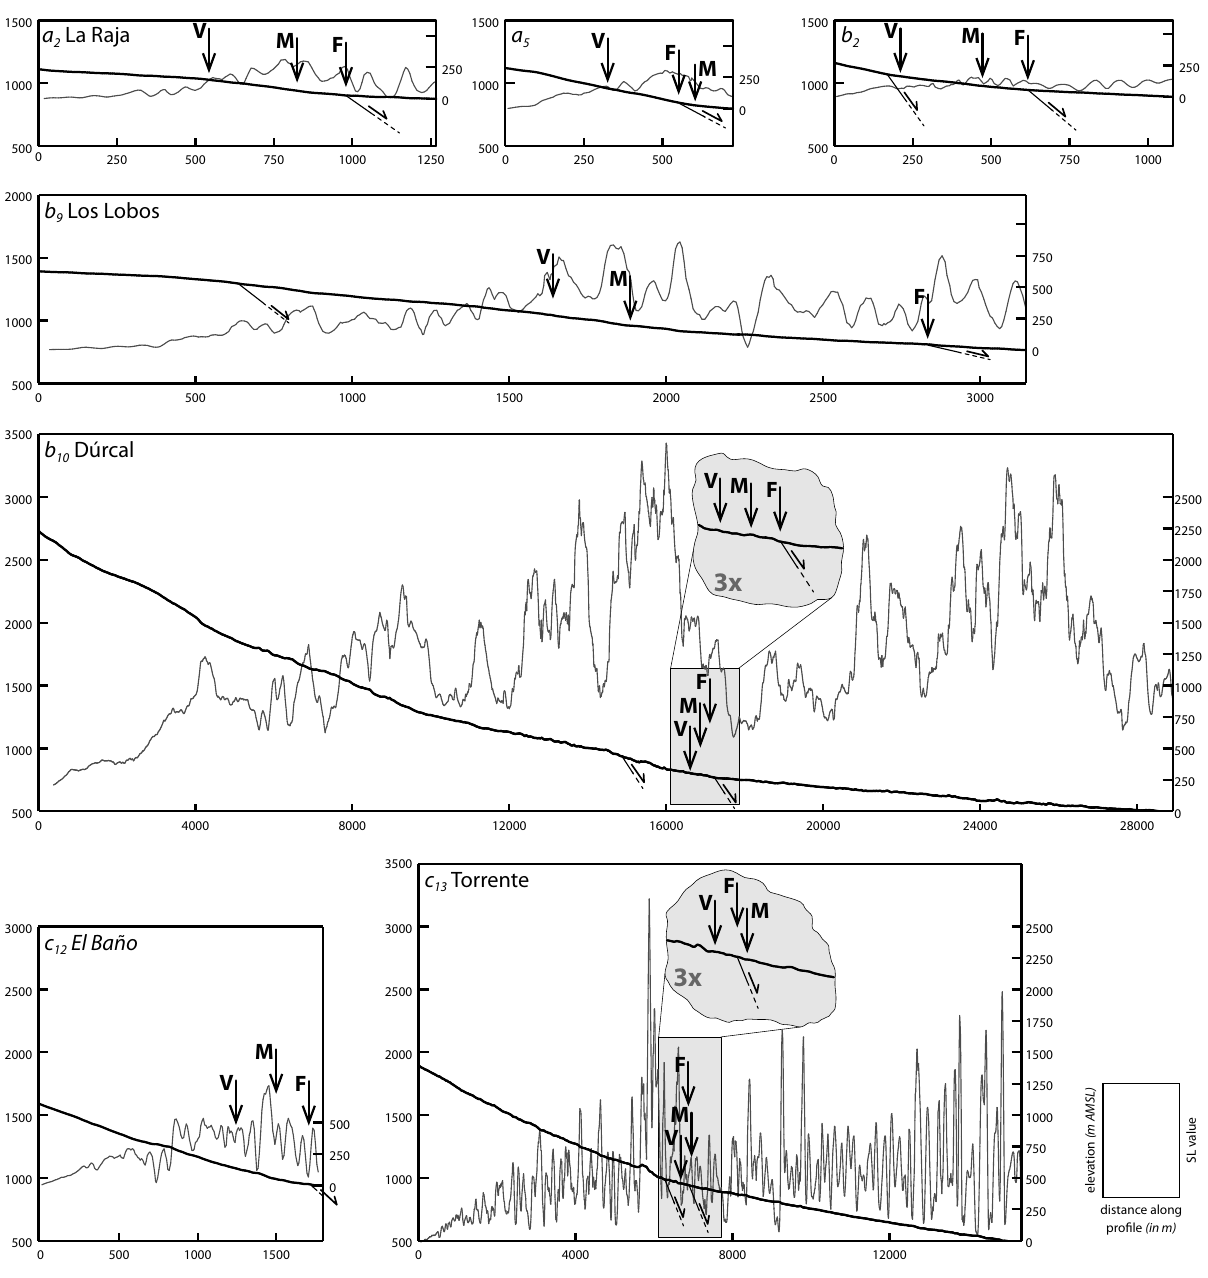
Figure 4. Calculated stream-length gradient index SL (gray line) for selected channel profiles (thick black line). Black arrows indicate the po-